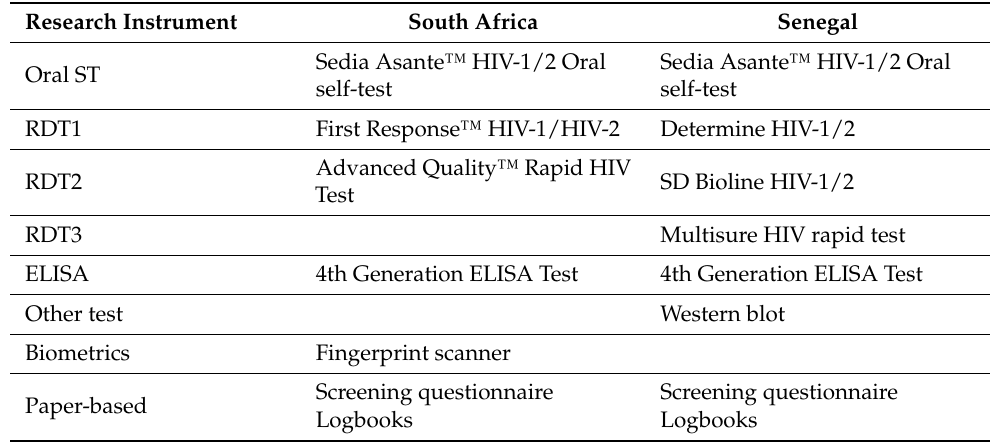
Table A1. Research instrument